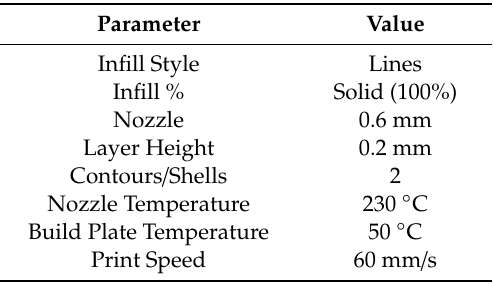
Table 1. Print Parameters Used for All Specimen Creation.